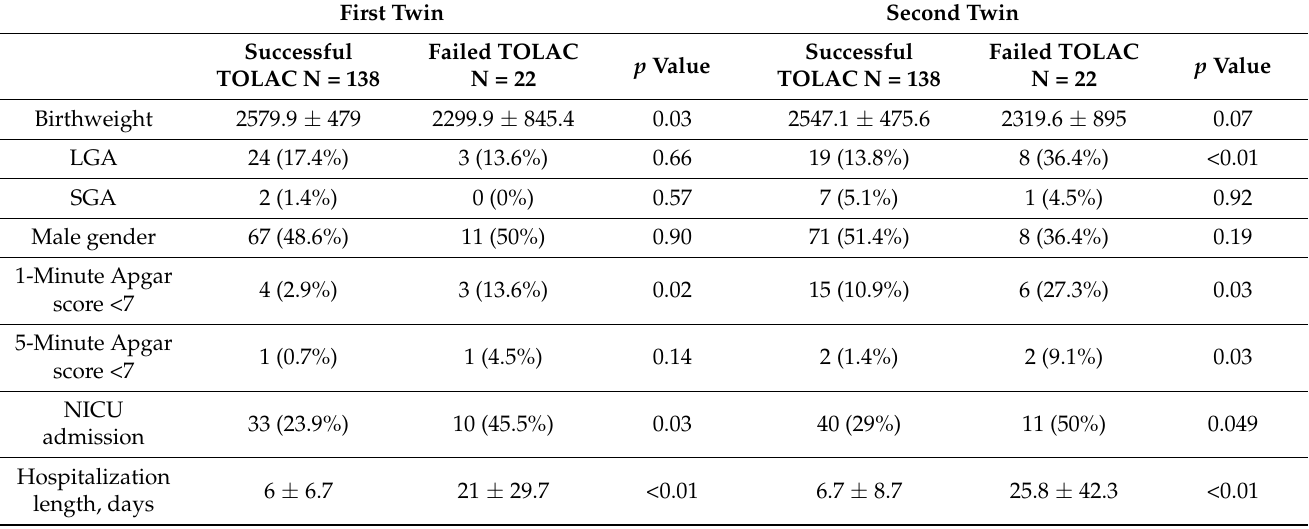
Table 3. Neonatal